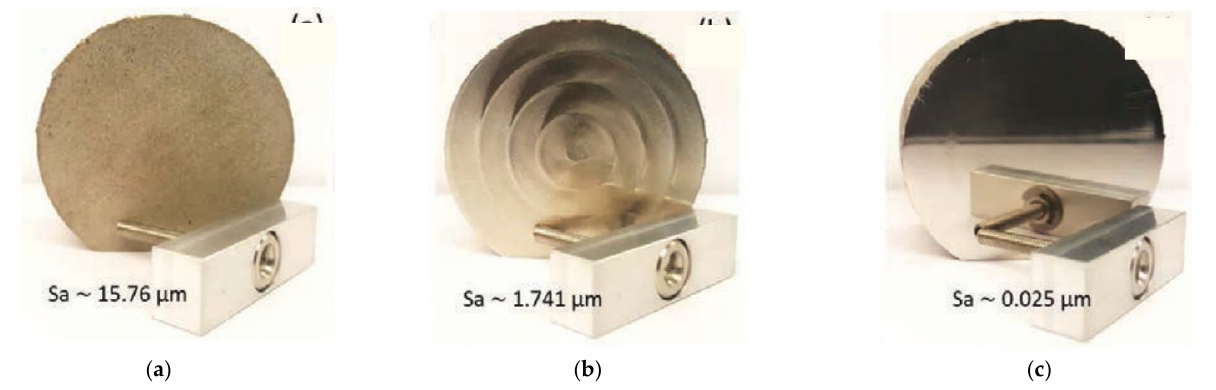
Figure 19. Surface finish of the part produced by powder bed laser melting: ( a ) without finishing; ( b ) after post-milling; ( c ) after fine abrasive finishing [97].